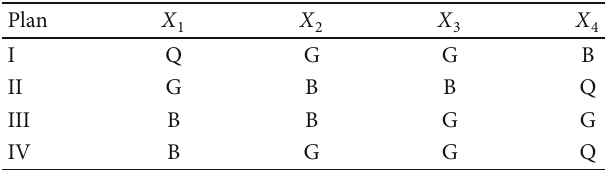
Table 3: Ratings of design plan of ES under the four criteria.